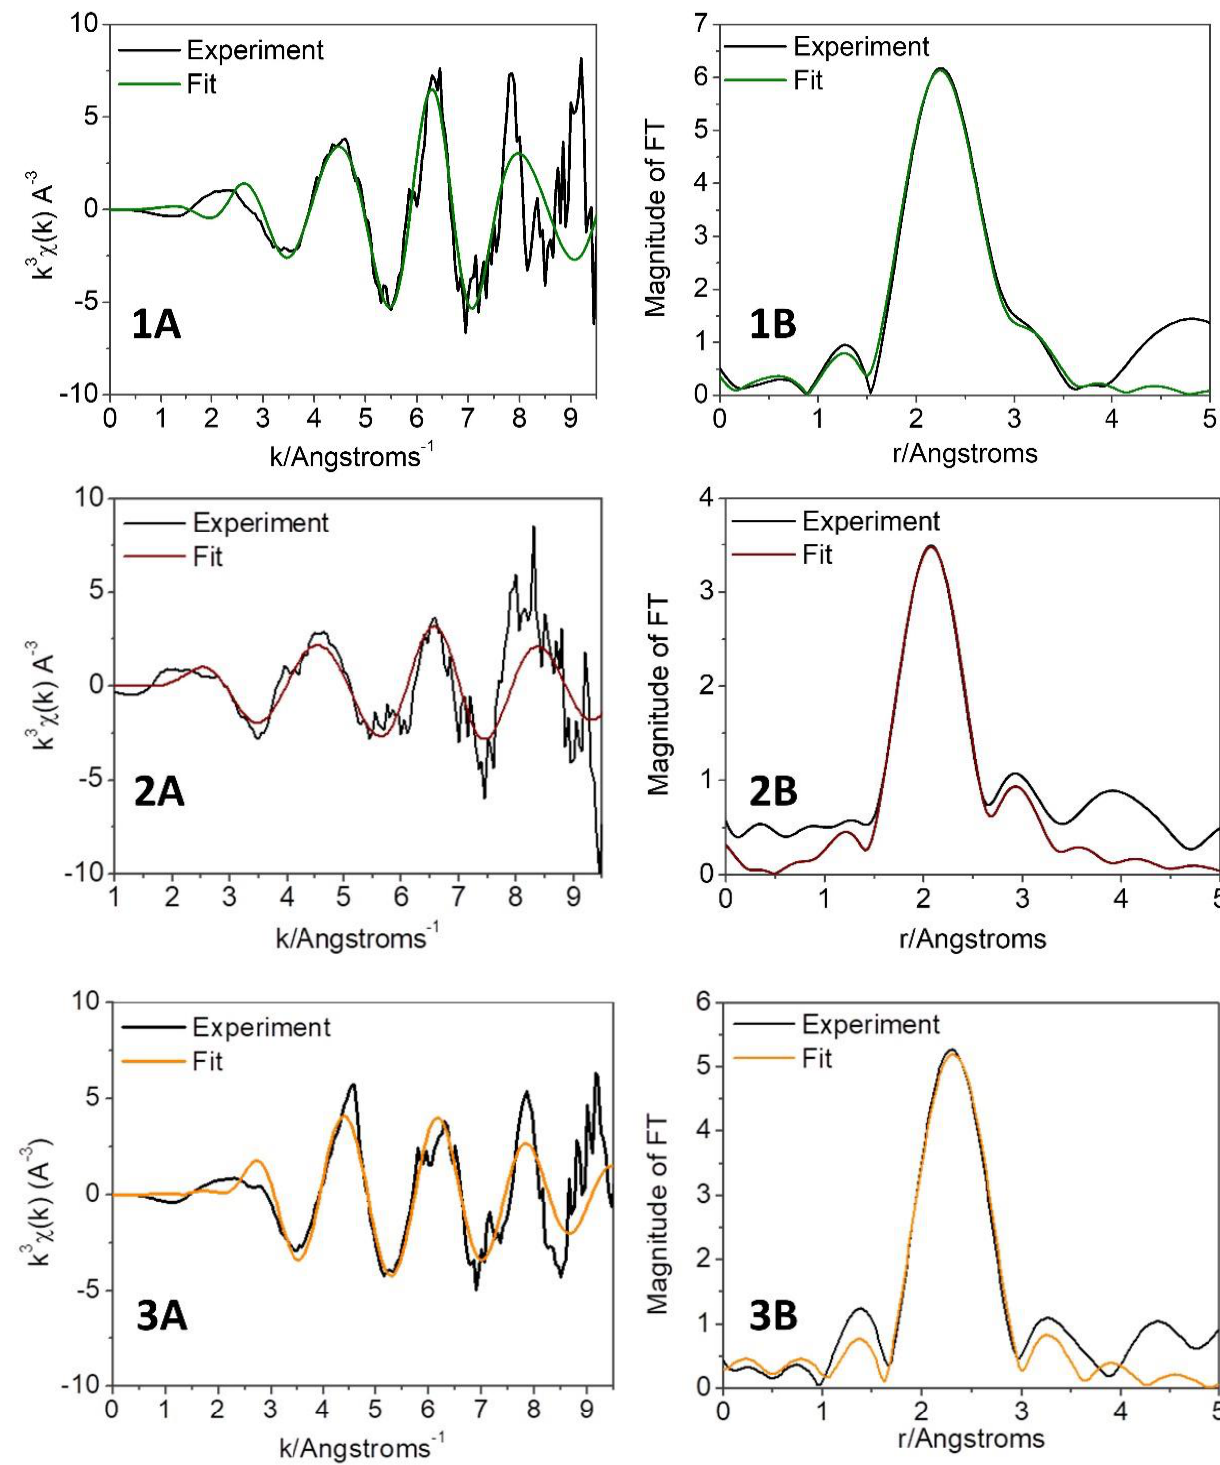
Figure 3. Experimental and simulated k 3 weighted EXAFS spectra of αSyn 1 – 15 SDS-Cu + ( 1A ), αSyn SDS-Cu + ( 2A ), and αSyn UVs -Cu + ( 3A ), and Fourier transform of αSyn 1 – 15 SDS-Cu + ( 1B ), αSyn SDS-Cu + ( 2B ), and αSyn UVs -Cu + ( 3B ) spectra. αSyn 1 – 140 500 μM, αSyn 1 – 15 500 μM, Cu 2+ 250 μM, SDS 50 mM, 125:1 lipid:protein ratio, phosphate buffer 20 mM pH= 7.4.